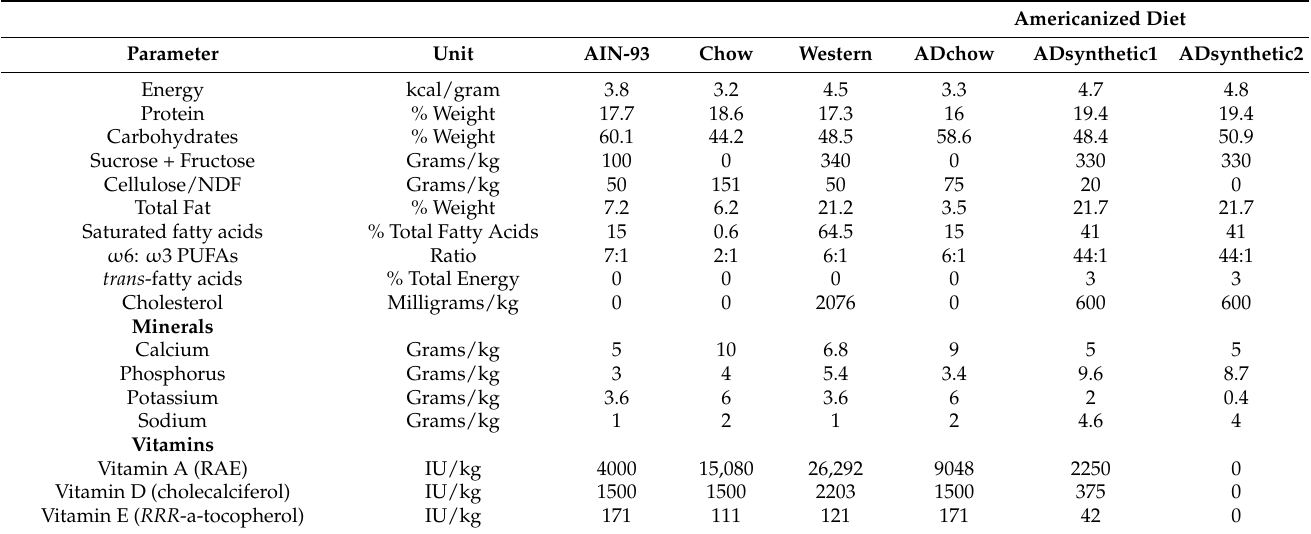
Table 1. Nutrient composition of experimental